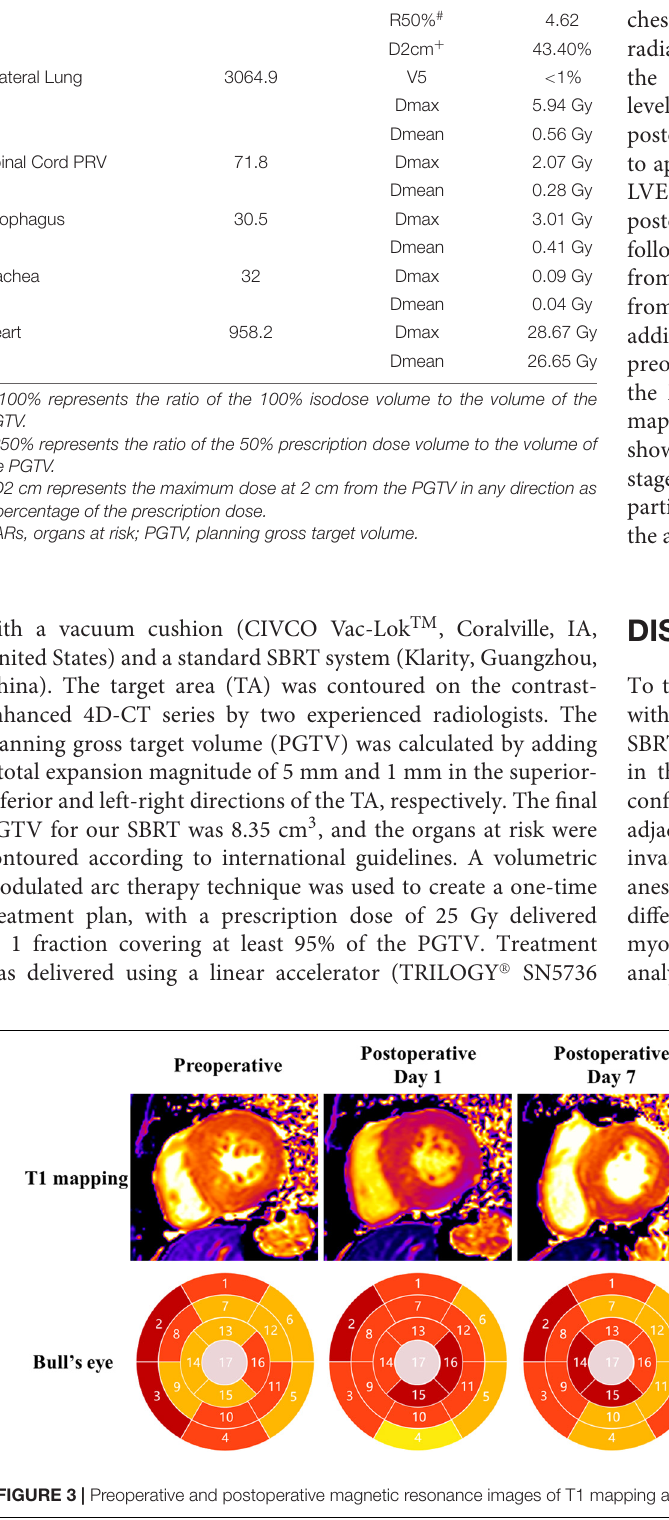
Frontiers in Medicine |